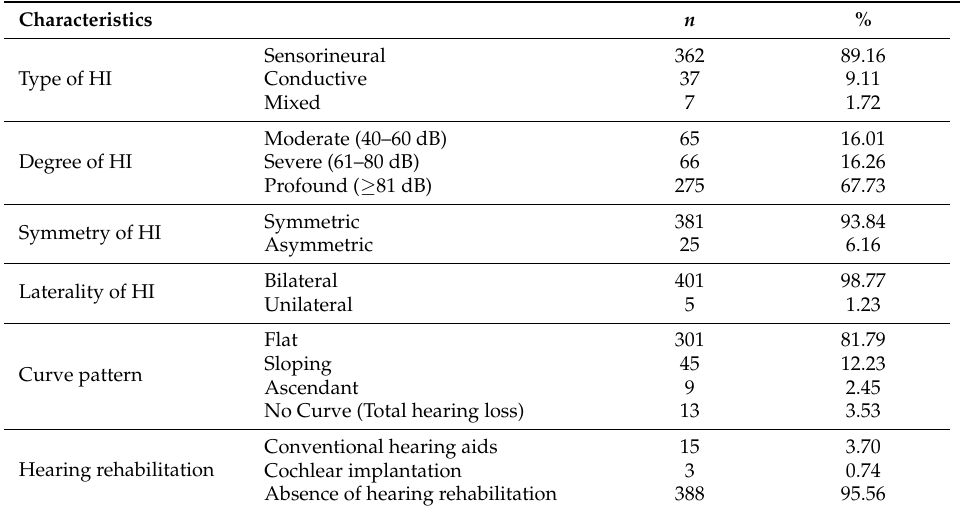
Table 2. Audiometric characteristics and hearing